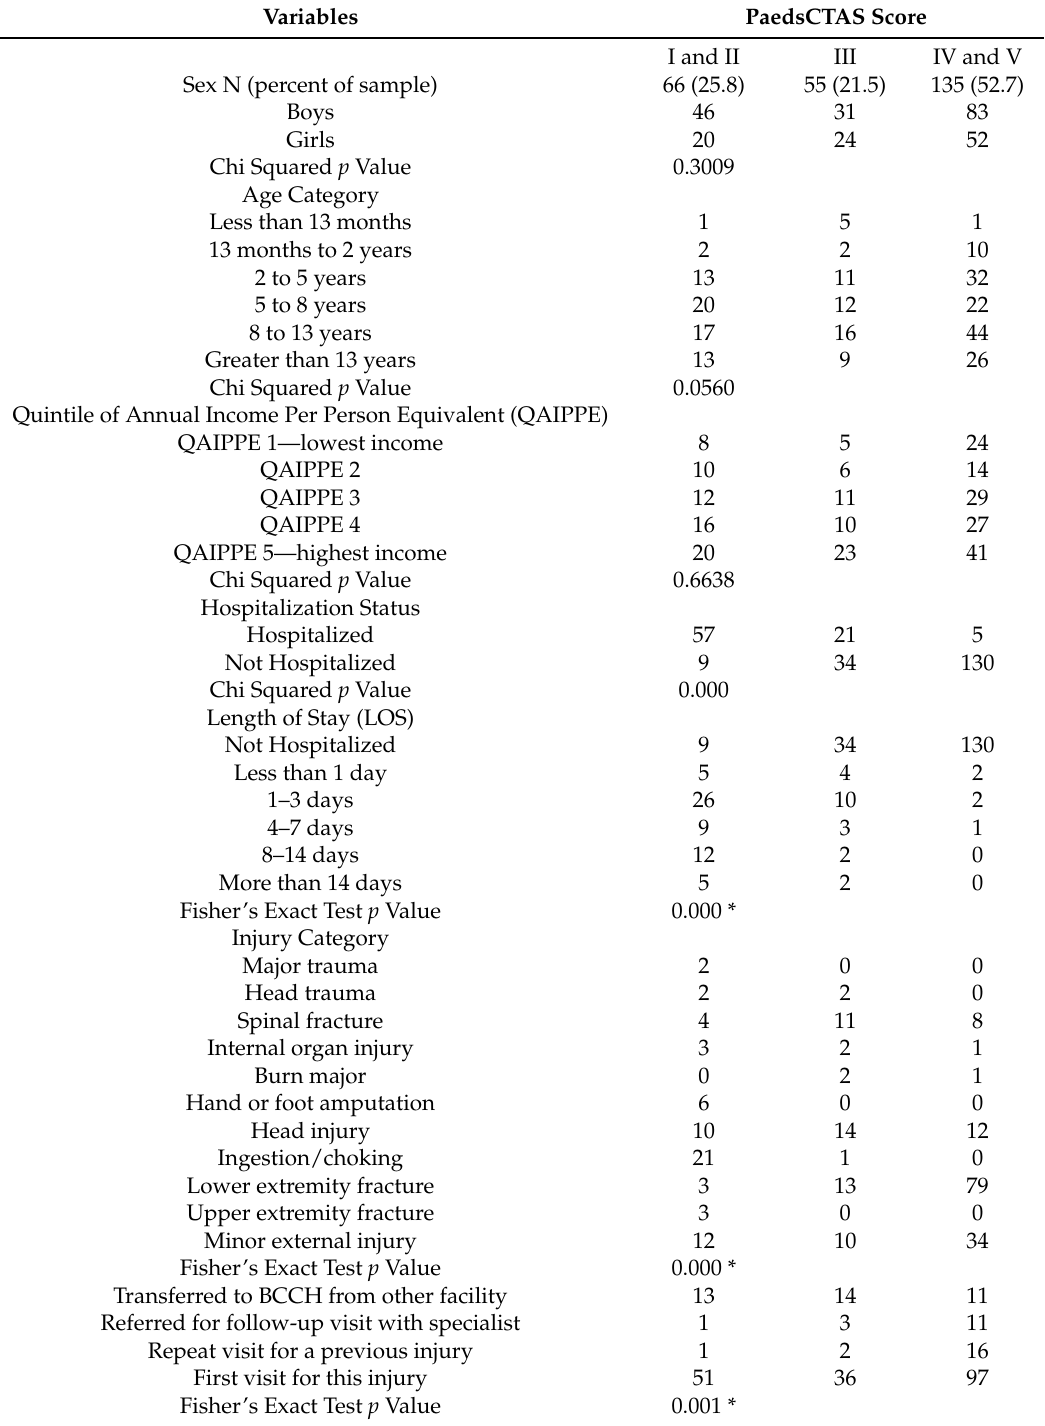
Table 2. Demographics by PaedsCTAS score with Chi squared or Fisher’s exact